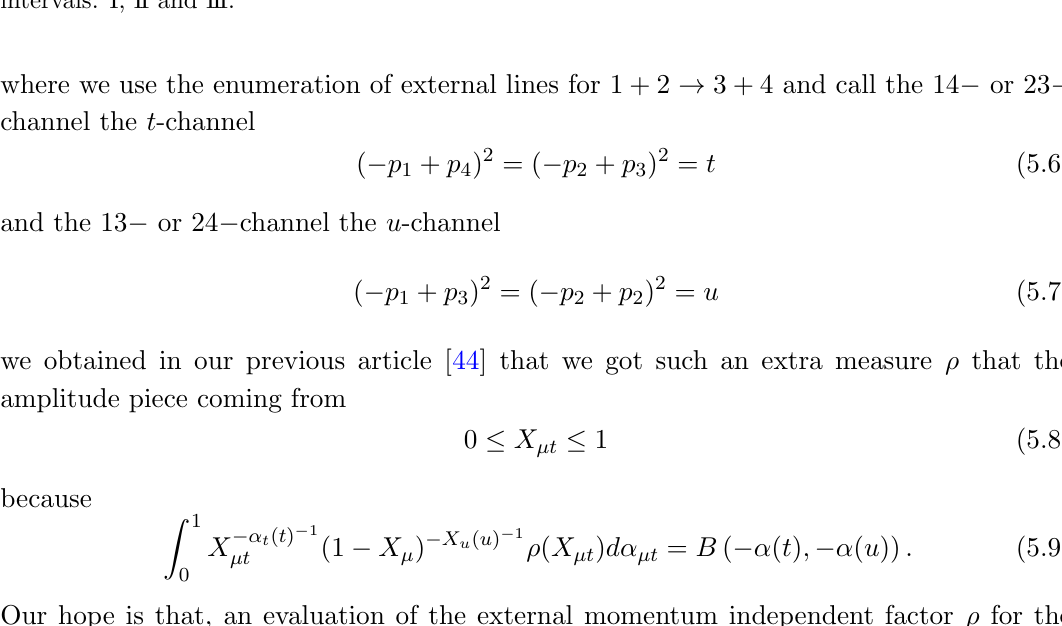
Figure 17 . Inequivalent con(cid:12)gurations of the four external lines on the Rieman-Sphere S 2 are A = 0 ; 1 ; 1 . The external line attachments is divided. S 2 topology’s circle is divided into three intervals: I, II and